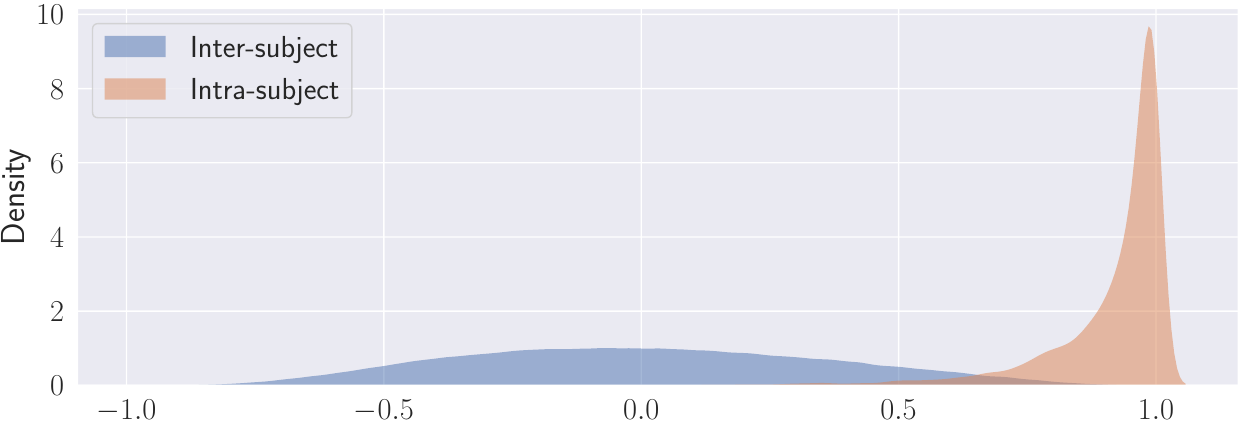
Figure 9. Kernel density estimation (KDE) plots for the distributions of the correlation coefficients calculated over all the stimuli for each subject (Intra-subject) and between subjects (Inter-subject). See text for